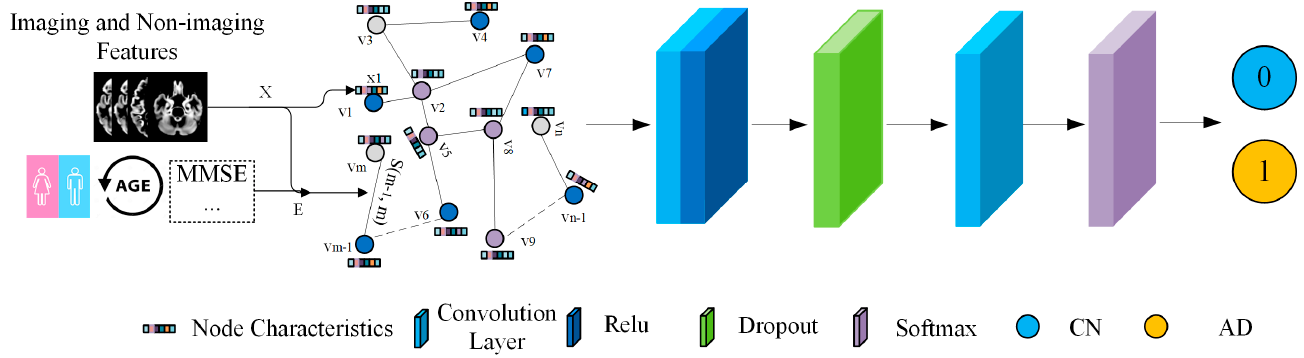
Figure 3. Illustration of the overall architecture of the GCN model for binary classification between the AD and CN classes.